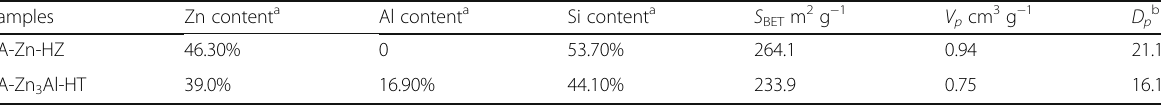
Table 1 The textural parameters of SA-Zn-HZ and SA-Zn 3 Al-HT Samples